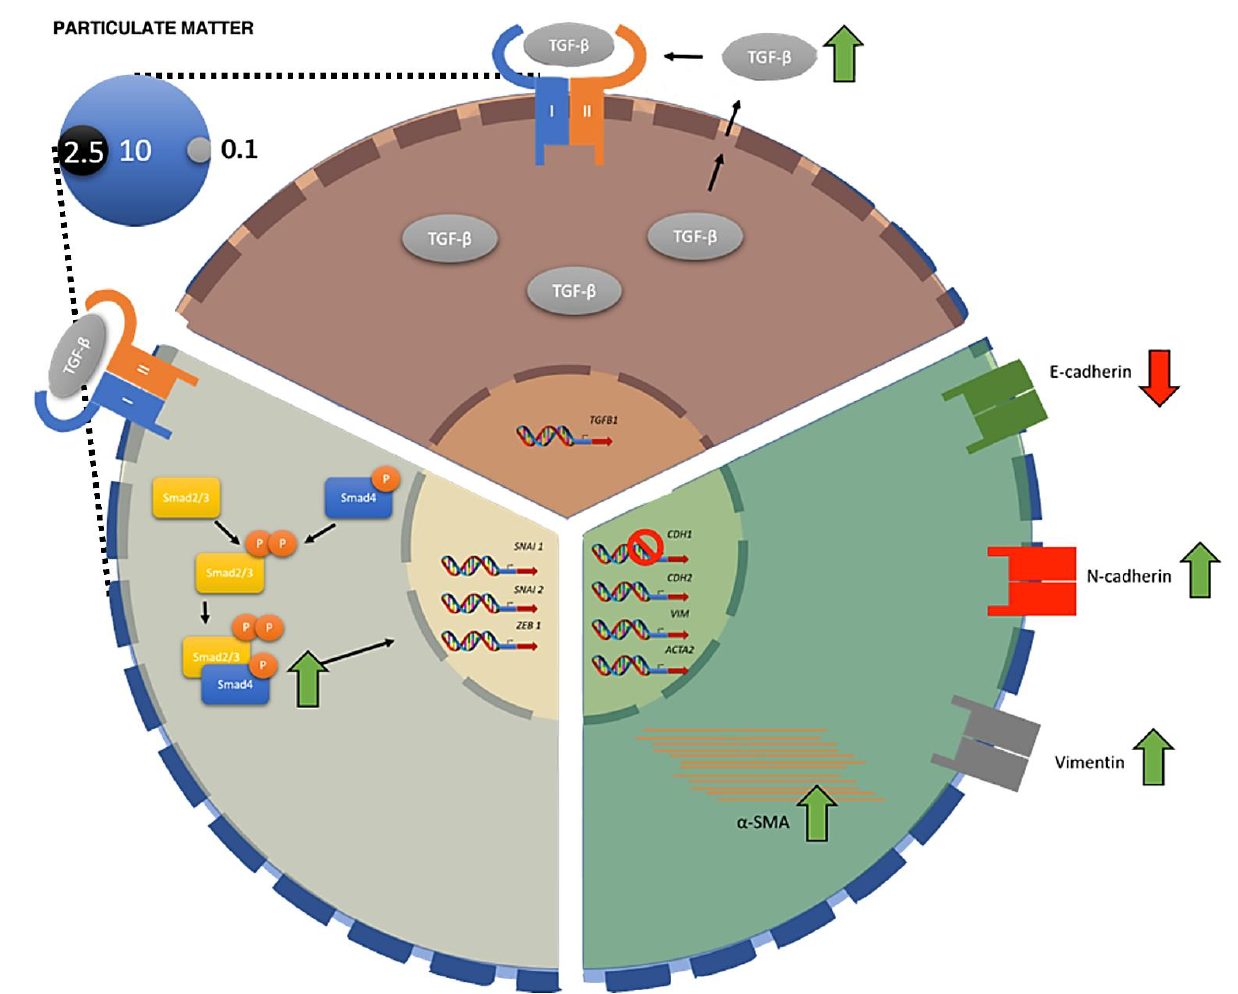
Figure 5. Schematic representation of the effect of PM 10 in EMT. PM 10 exposure cause overexpression of TGFB1 in A549 cells, promoting the autoinduction of TGF- β signaling. As a result, SNAI1 (Snail), SNAI2 (Slug), ZEB1 (ZEB1), CDH2 (N-cadherin), ACTA2 ( α -SMA), and VIM (vimentin) genes are overexpressed, while CDH1 (E-cadherin) is downregulated in a TGFB1 -dependent way. PM 10 also induces phosphorylation of SMAD2/3 and an increase in protein levels of SMAD4 in a TGFB1 -independent way. These alterations predispose cells to the acquisition of an invasive phenotype, as evidenced by the invasion assay. Stop signal (in CDH1) represents gene repression, while green and red arrows represent increase and decrease of protein levels, respectively.